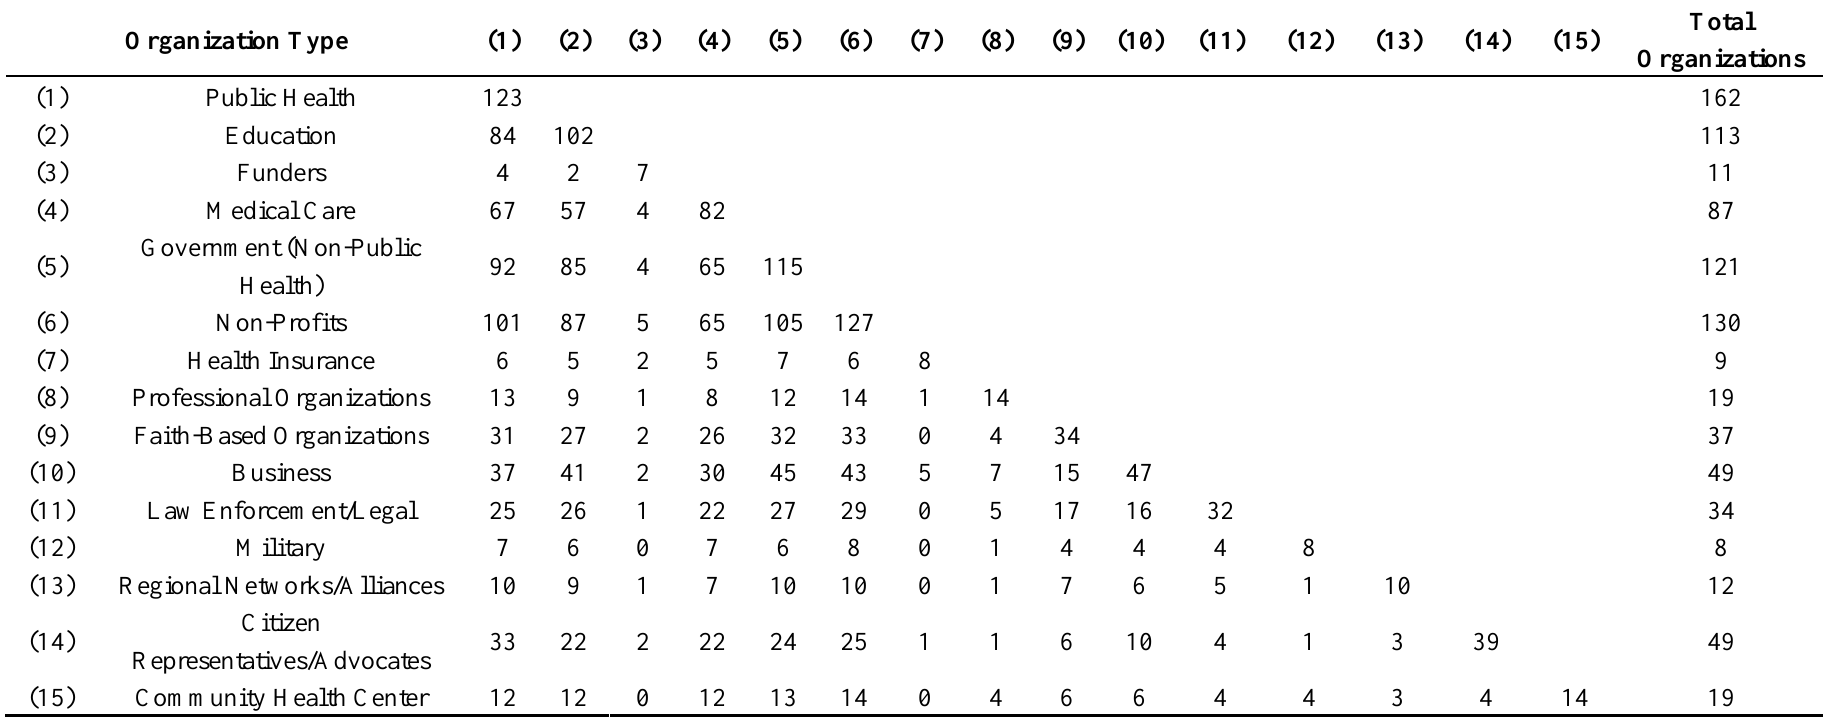
Table 1. Frequency of partnerships between organization types across PARTNER PHCs ( n =